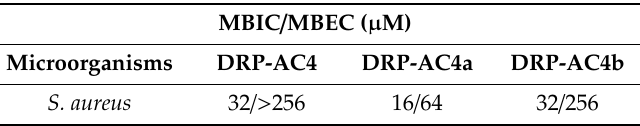
Table 4. Inhibitory and eradicative activities of DRP-AC4, DRP-AC4a, and DRP-AC4b against S. aureus biofilms. MBIC stands for minimum biofilm inhibitory concentration and MBEC means minimum biofilm eradication